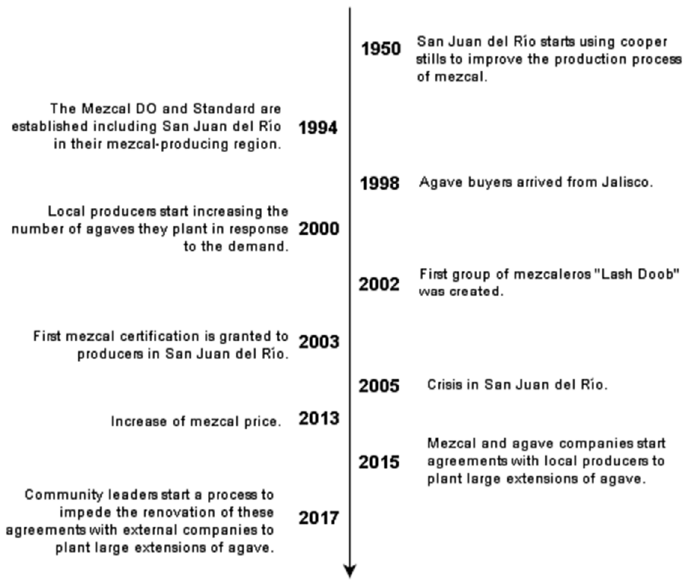
Figure 3. Main events regarding mezcal and agave production in San Juan del Río. (Sources: Interview data and San Juan del Río Biocultural Protocol, 2020.)